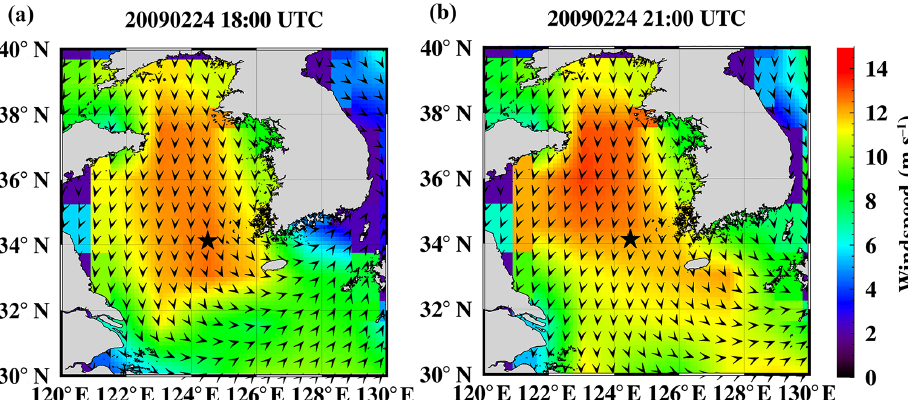
Figure 6. The sea surface wind fields at 18:00 (a) and 21:00UTC (b) of the first case that occurred at 20:30UTC on 24 February 2009. The accident location is marked with a black star. The arrows represent the sea surface wind